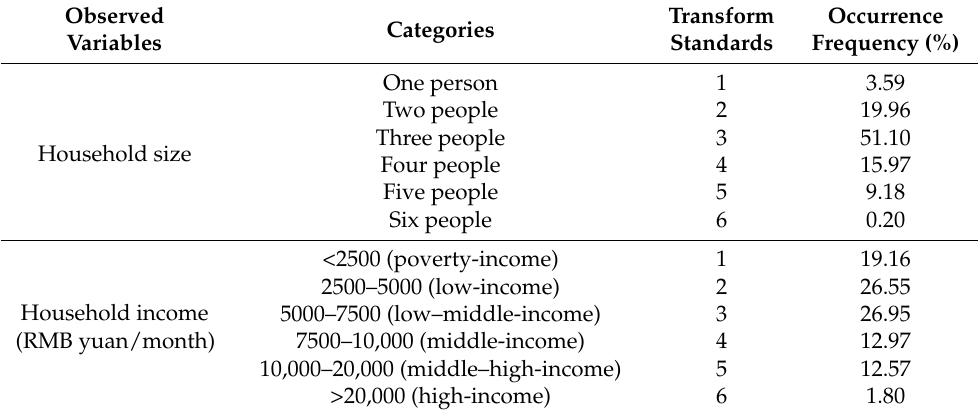
Table 2. The transformation standards and occurrence frequencies of respondents’